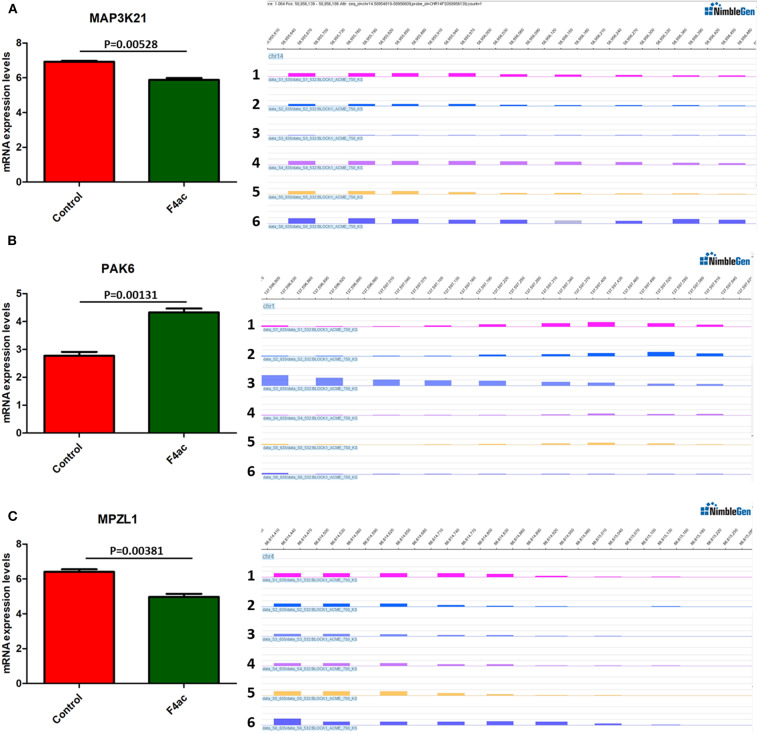
DNA methylation and expression of MAP3K21, PAK6, and MPZL1 in ETEC F4ac infected cells compared to uninfected cells. (A)
MAP3K21 was down-regulated and hypermethylated. (B)
PAK6 was up-regulated and hypomethylated. (C)
MPZL1 was down-regulated and hypermethylated. Panels 1–3 and 4–6 indicate the differentially methylated peaks in control and F4ab infected cells by MeDIP-chip. P < 0.01 and P < 0.05 indicate highly significant difference and significant difference between uninfected and F4ab infected cells, respectively.